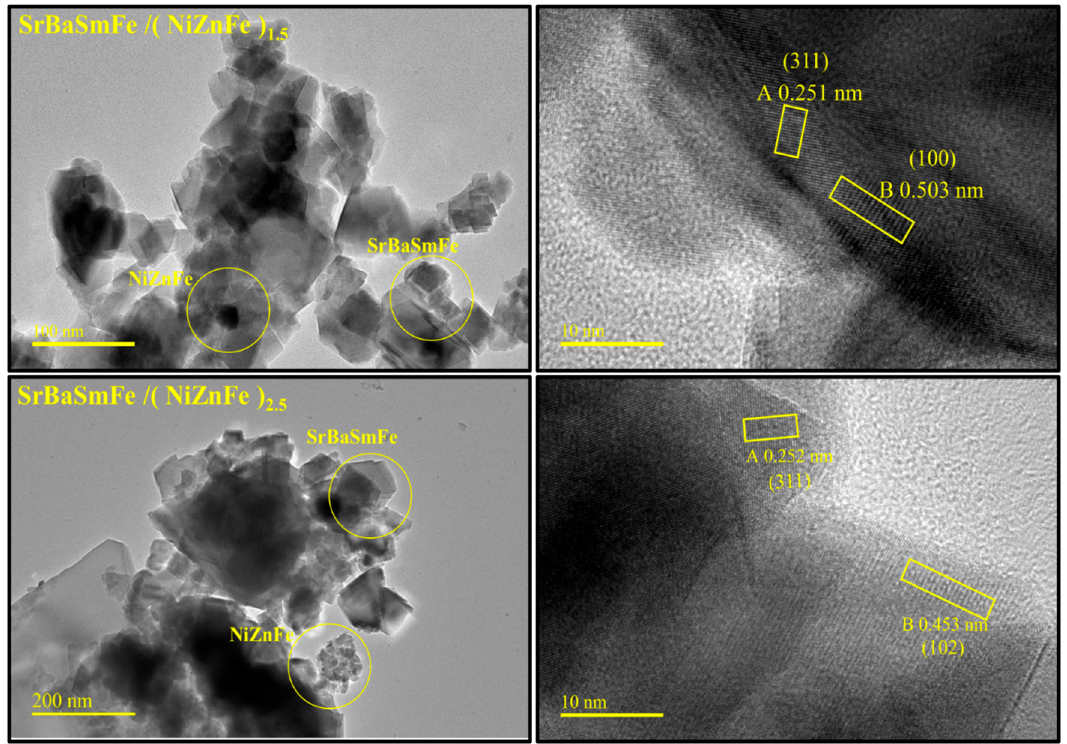
Figure 5. TEM (left) and HR-TEM (right) images of hard/soft ferrite SrBaSmFe/(NiZnFe) x NCs with x = 1.5 and 2.5. Nanomaterials 2020 , 10 , x FOR PEER REVIEW